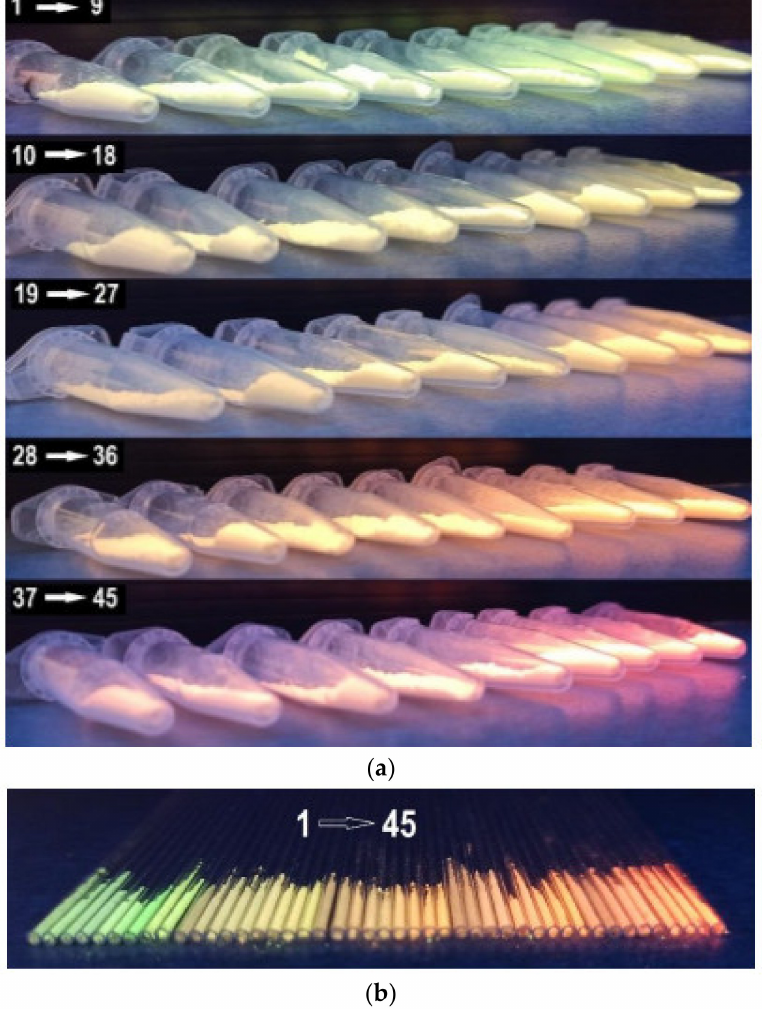
Figure 8. Images of CaMo y W 1 − y O 4 :Eu 3+ x /Tb 3+ 1 − x under UV in ( a ) Eppendorf tubes and ( b ) glass